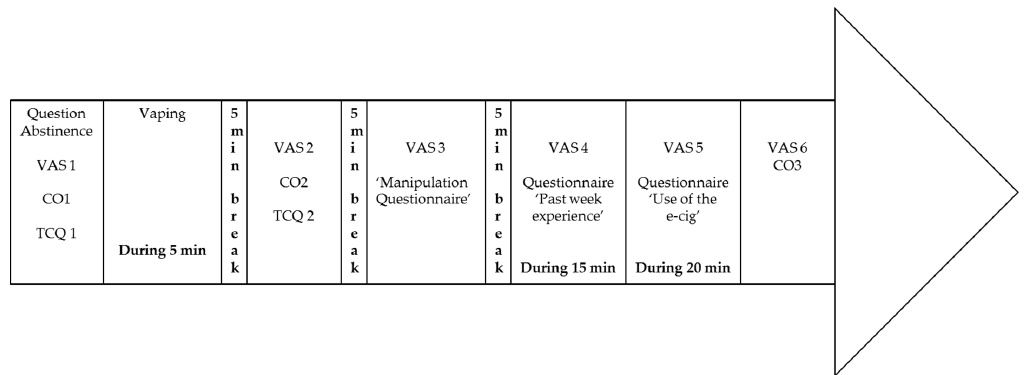
Figure 2 . Timeline of the second (experimental) session. Please provide clearer figure. Figure 2. Timeline of the second (experimental) session. Please provide clearer